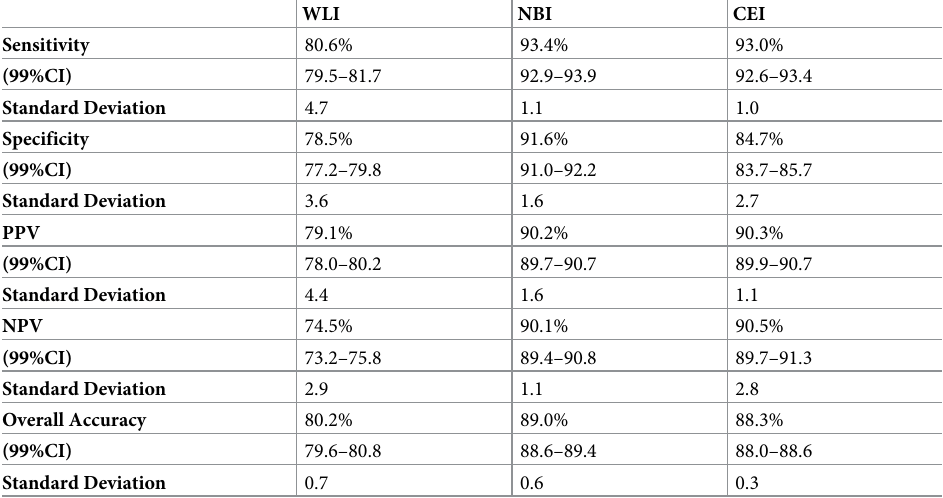
Table 3. Diagnostic performance for adenomatous polyps in the AlexNet system of the second-generation model.